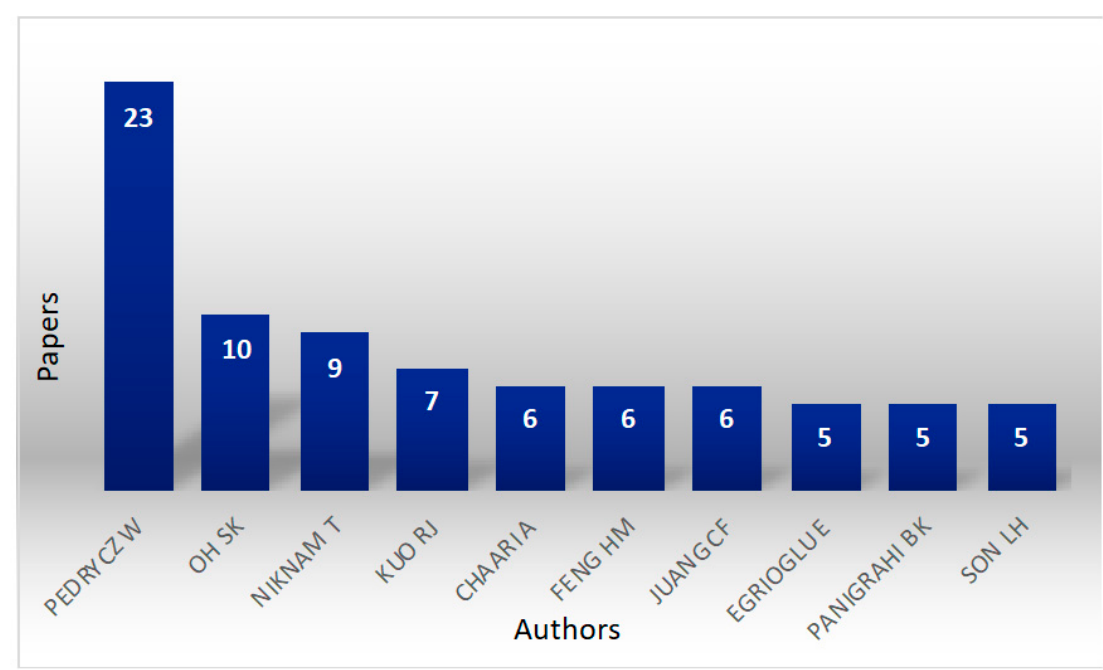
Figure 12. Record by authors for topic: Optimization fuzzy clustering with particle swarm optimization.